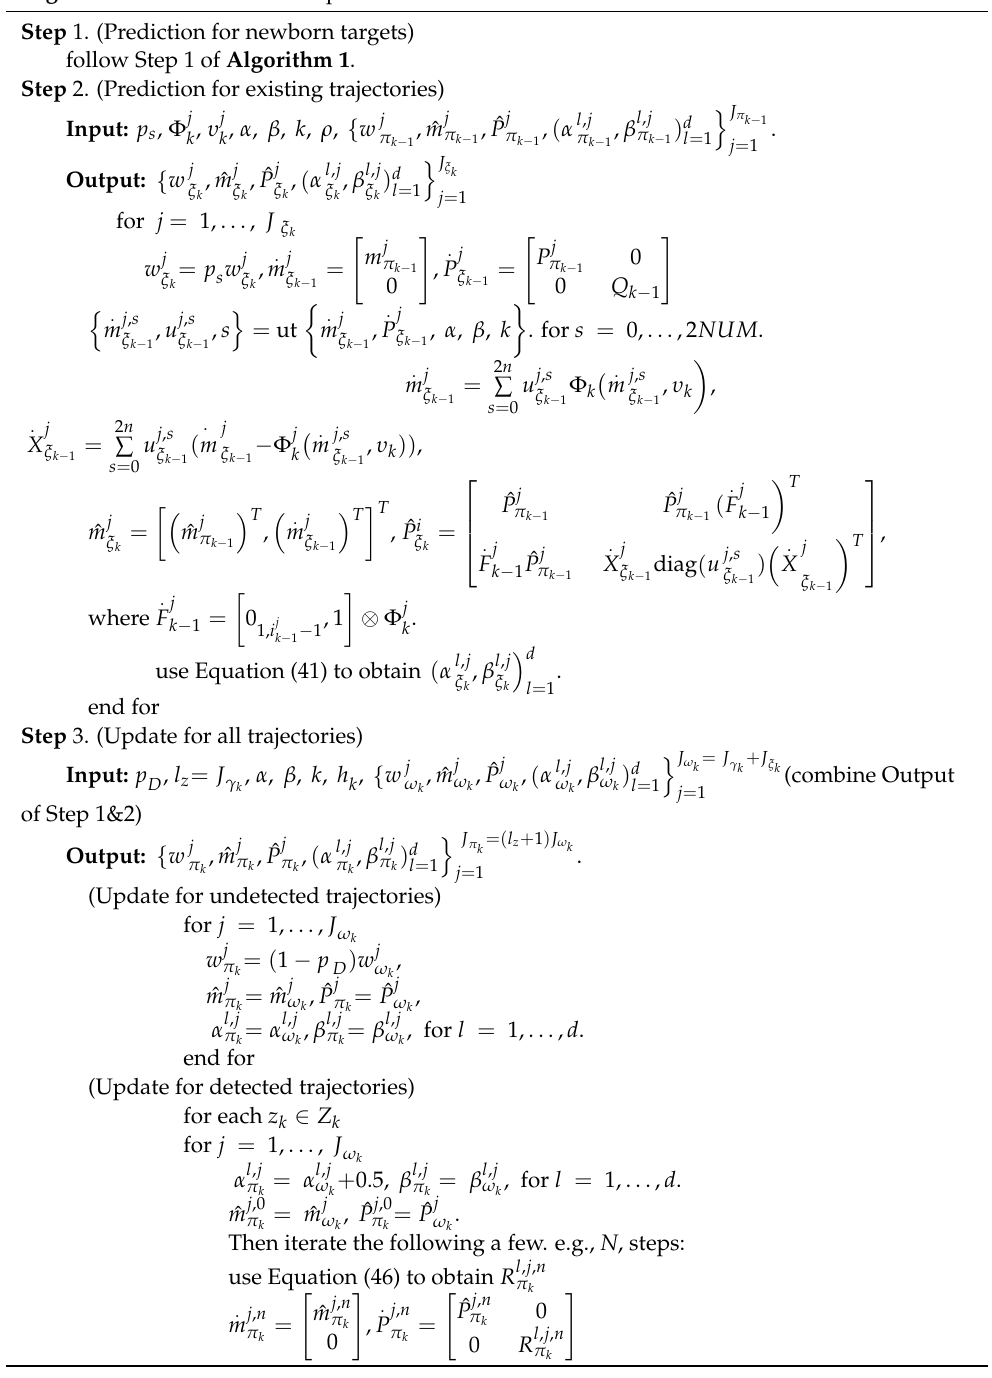
Algorithm 2. Prediction and Update for the AUK-VB-TPHD